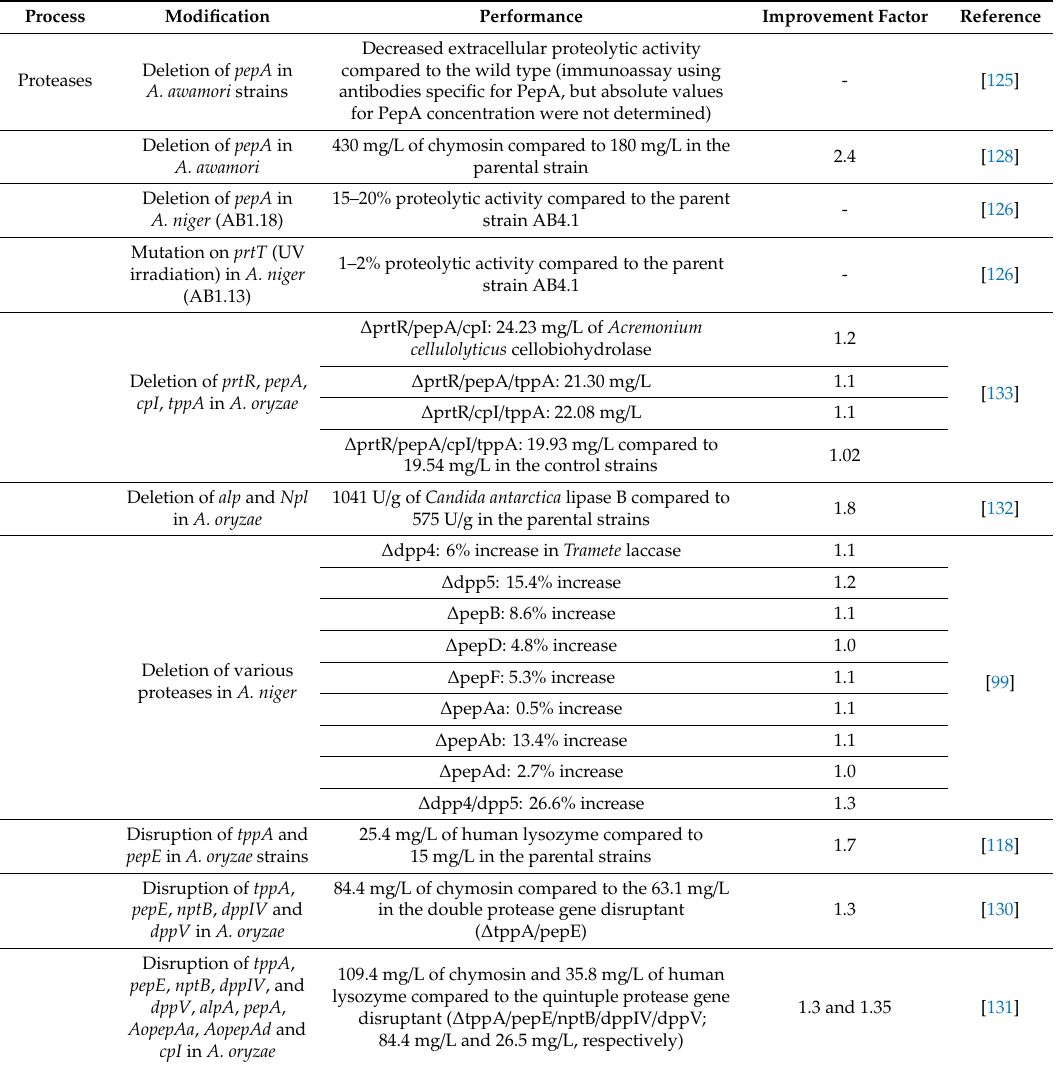
Approaches for improving recombinant protein production through disruption of protease